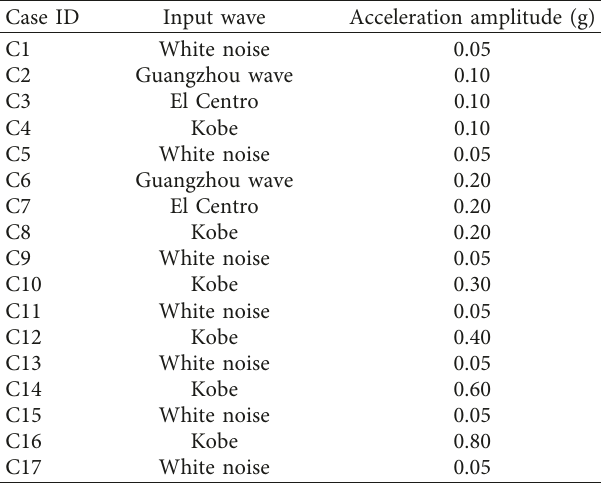
Table 4: Test cases for the shaking table